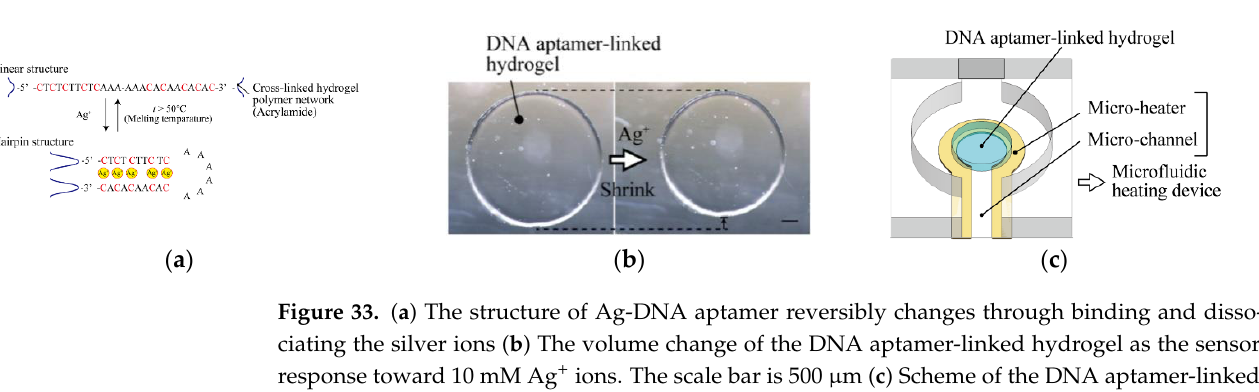
Figure 32. ( a ) Microdroplet channel layout for the SERS detection of mercury(II) ions; ( b ) SERS signal change for the microdroplets measured according to aptamer DNA release from the nanoparticle surface in the presence of mercury(II) ions, forming a stable T-Hg 2+ -T mediated hairpin structure; ( c ) Peak intensity ratios (1585 (Cy3)/489(PDMS)) as a function of mercury(II) concentration [119].